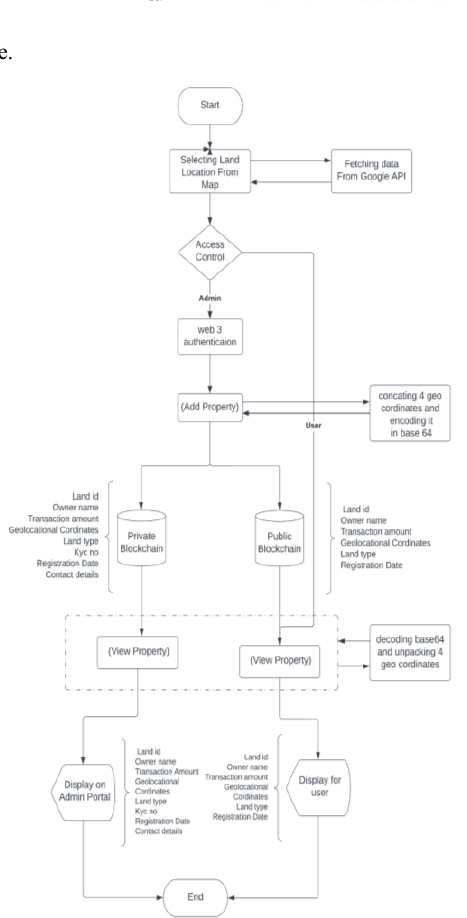
Fig. 4. Flowchart for accessing land